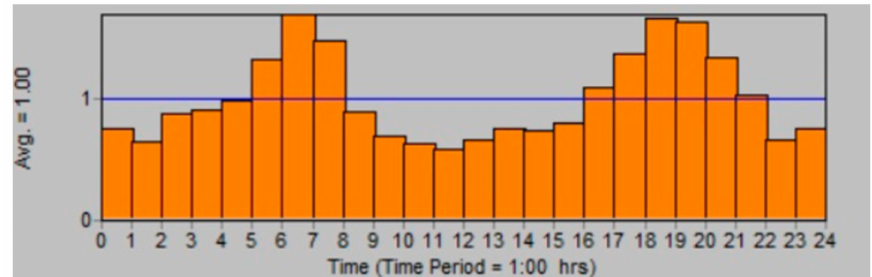
Figure 4. Daily water consumption pattern for a selected domestic customer.